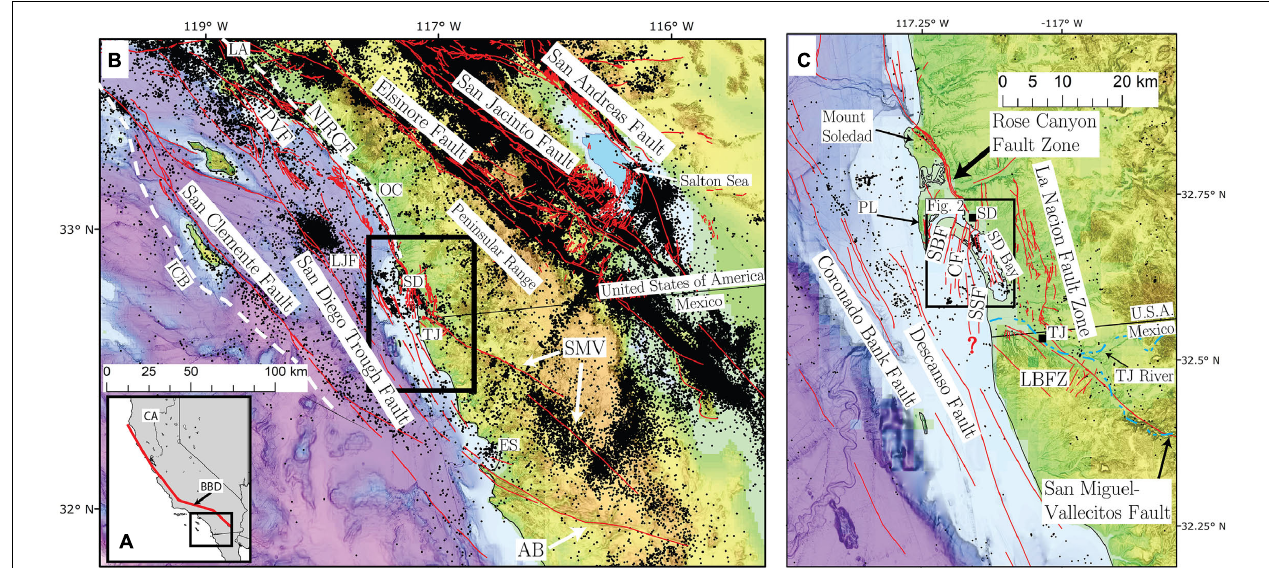
FIGURE 1 | (A) Map of the southwestern United States and northern Baja California, Mexico. Red line marks general trace of the San Andreas Fault. Black box corresponds to location of (B) . (B) Map of southwestern California and northwestern Baja California, Mexico. Quaternary active faults are shown in red and the transpeninsular faults are labeled (i.e., AB and SMV). White dashed line indicates boundary of ICB. Regional seismicity (black circles) between 1981-2019 are from Hauksson et al. (2012) and Ross et al. (2019). Black box corresponds to location of (C) . (C) Overview map of the San Diego region with regional faults (red lines). The faults that trend south away from San Diego Bay (i.e., SBF, CF, SSF) likely continue beyond the international border, but lack reliable data to extend the mapped trace. Black box marks location of Figure 2 . AB, Agua Blanca fault; BBD, Big Bend Domain of the San Andreas Fault; CA, California; CF, Coronado fault; ES, Ensenada; LJF, La Jolla Fan; LBFZ, Los Buenos fault zone; ICB, Inner Continental Borderland; NIRCF, Newport-Inglewood-Rose Canyon fault; OC, Oceanside; PL, Point Loma; SD, San Diego; SMV, San Miguel-Vallecitos fault; SBF, Spanish Bight fault; SSF, Silver Strand fault; TJ, Tijuana. Fault traces north of the international border are from the USGS fault database (USGS, 2019) and the USGS offshore fault database (Walton et al., 2020a); faults south of the border are from Fletcher et al. (2014). Background topography and bathymetry are from ESRI topography and the National Centers for Environmental Information Southern California Coastal Relief Model (v2) (Calsbeek et al.,